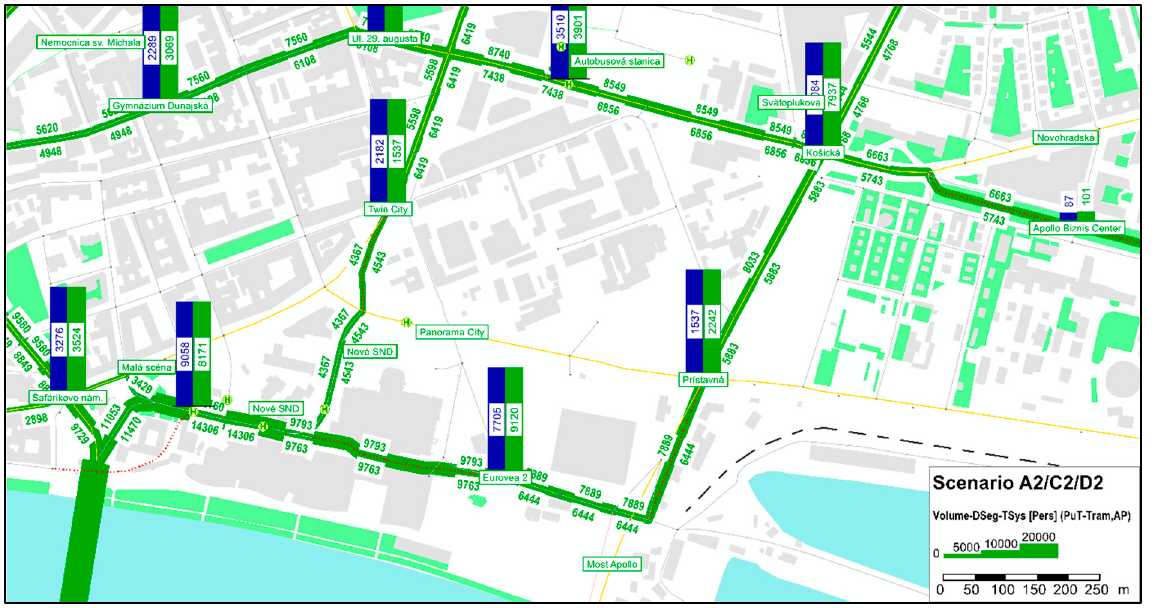
Figure 10. Scenario of a public transport model as an output .